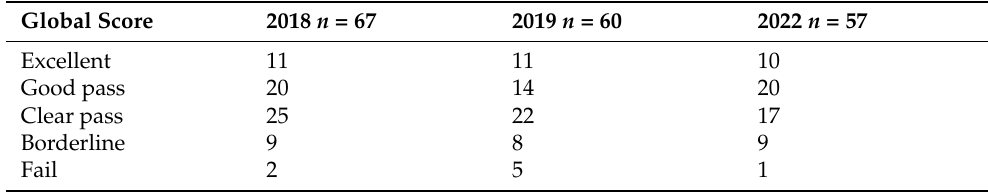
Table 5. Performance in the suture OSCE for the class of 2018, 2019, and 2022. Global Score 2018 n = 67 2019 n = 60 2022 n = 57 Excellent 11 11 10 Good pass 20 20 Clear